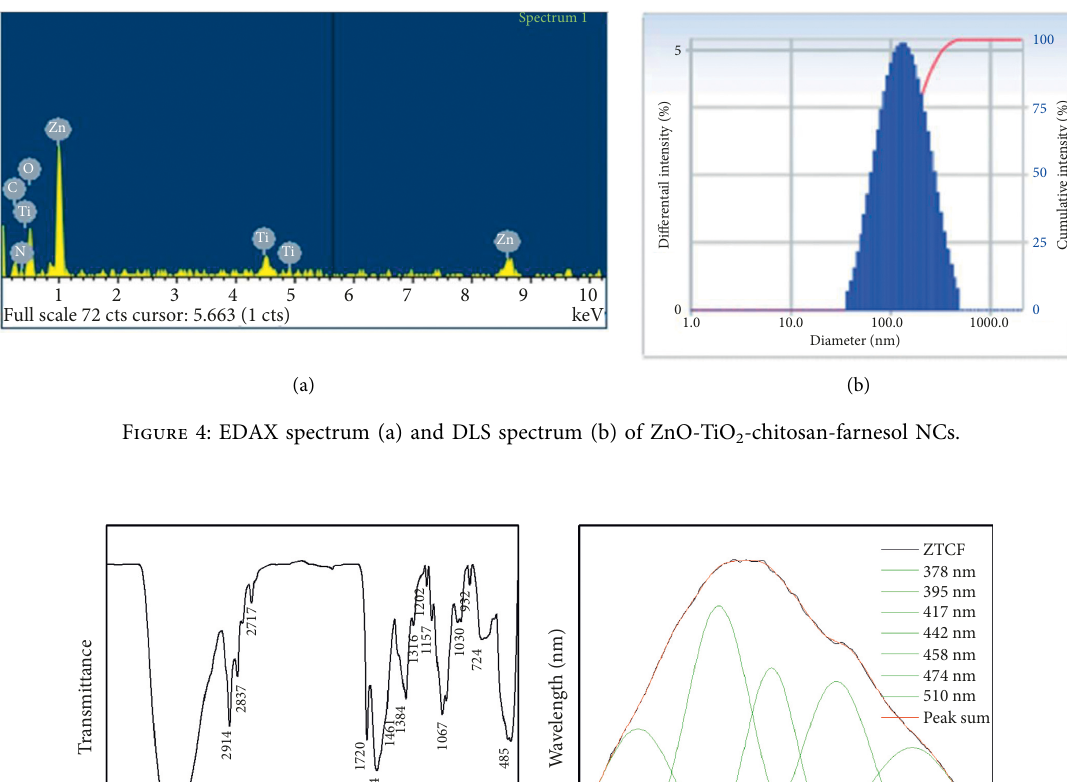
Figure 5: FTIR spectrum of ZnO-TiO 2 -chitosan-farnesol NCs (a). PL spectrum of ZnO-TiO 2 -chitosan-farnesol NCs (b).